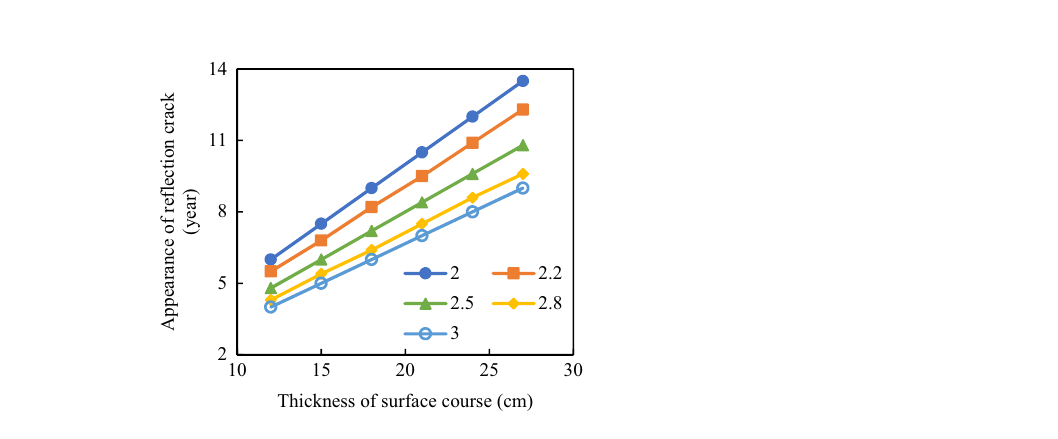
Figure 18. Reflective crack appearance times for different pavement